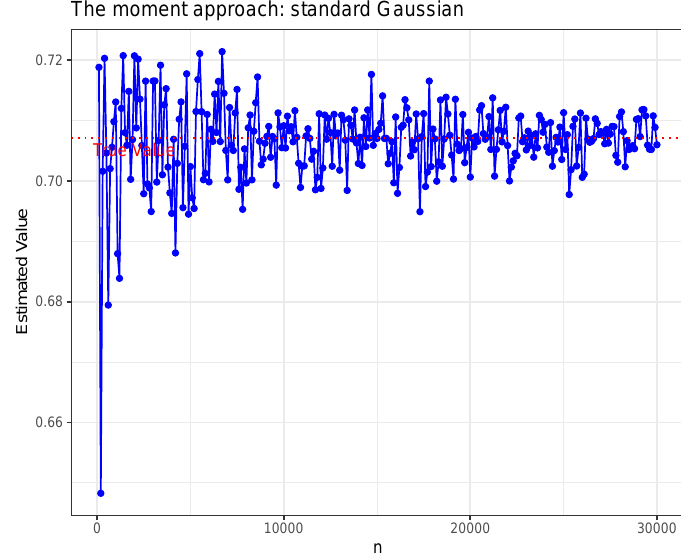
Figure 1. standard Gaussian.